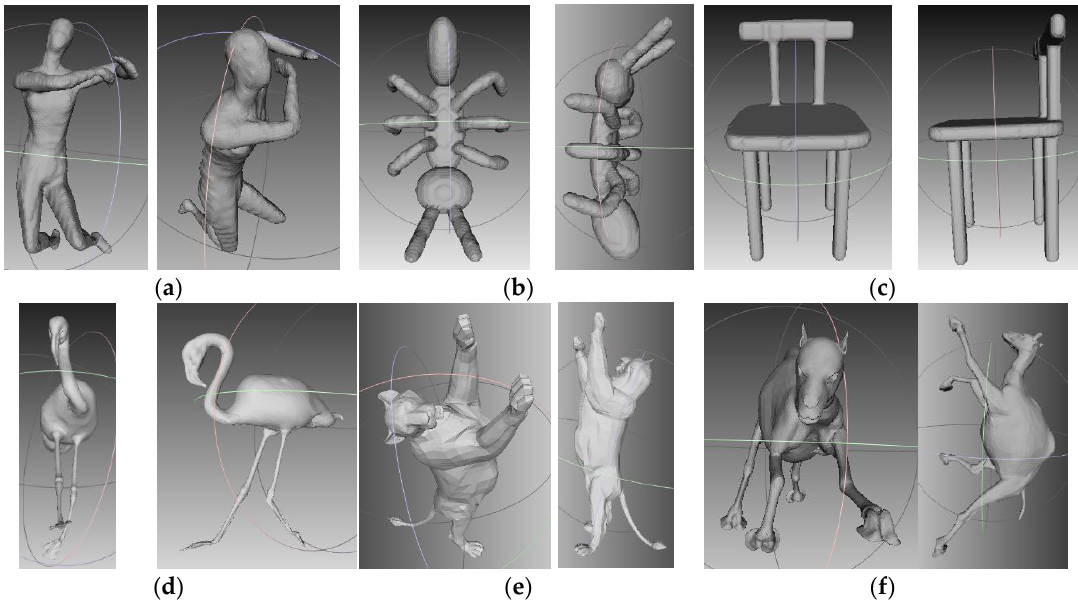
Figure 14. Models in McGill 3D shape benchmark and Sumner dataset. ( a ) man; ( b ) ant; ( c ) chair; ( d ) flamingo; ( e ) lion; ( f ) camel.